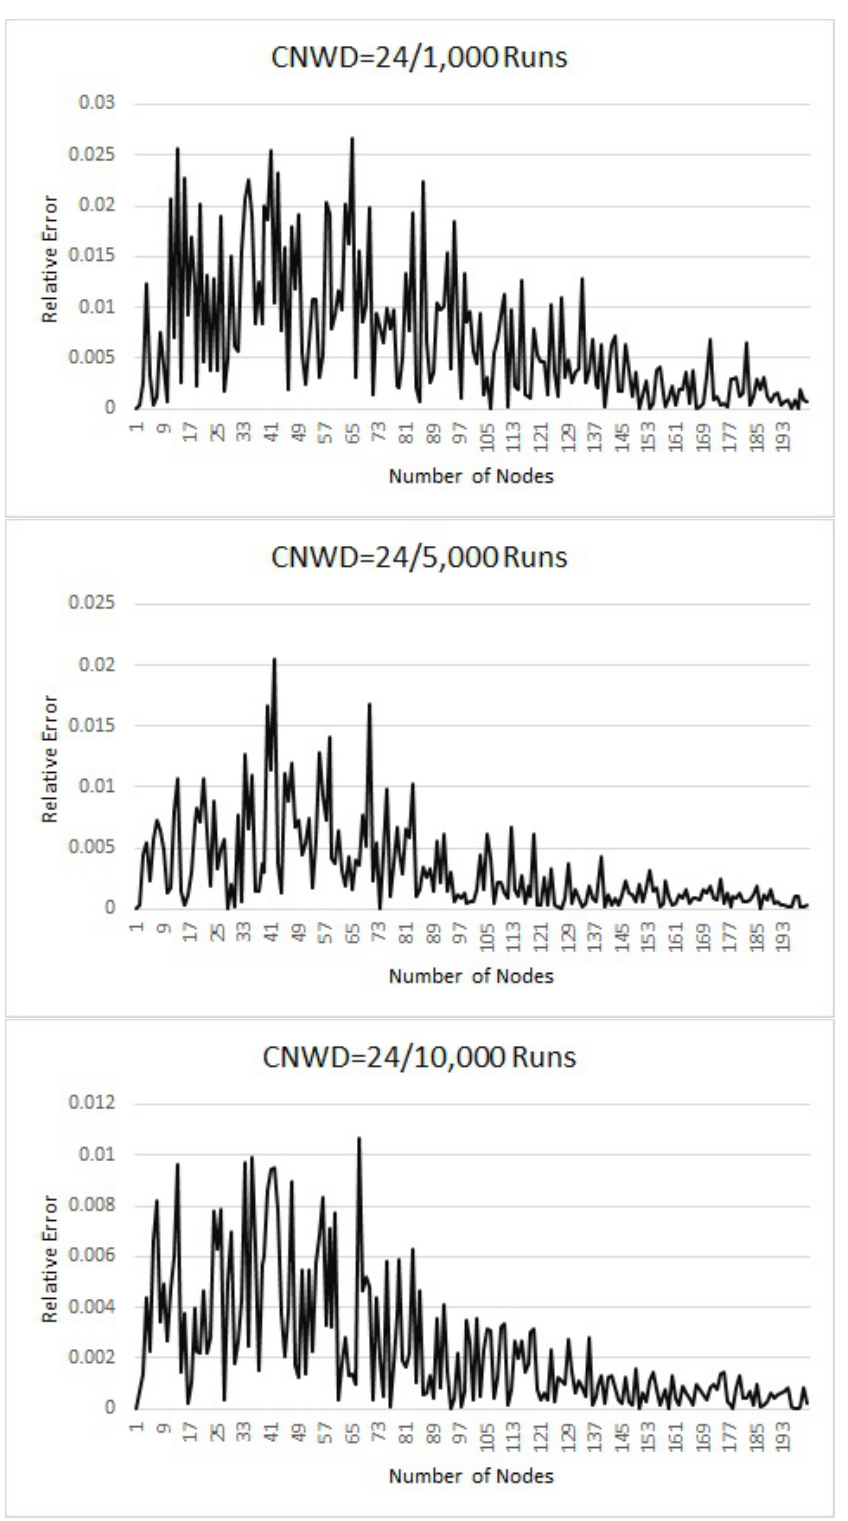
Figure 4. Theoretical vs. Simulated results for CNWD =